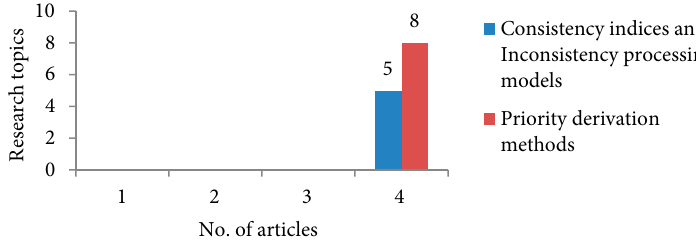
Fig. 4. The distribution of researches on the main developments of statistical approaches Compared with the previous approaches in multiplicative, additive PCMs and